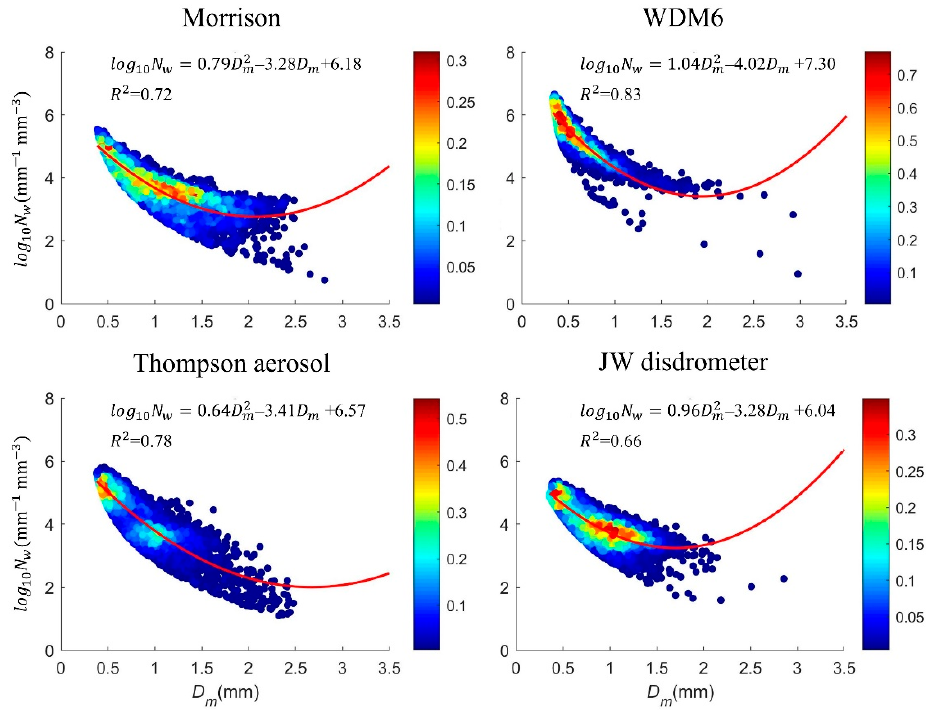
Figure 4. Density and fitting curves between D m and log 10 N w of different double-moment schemes